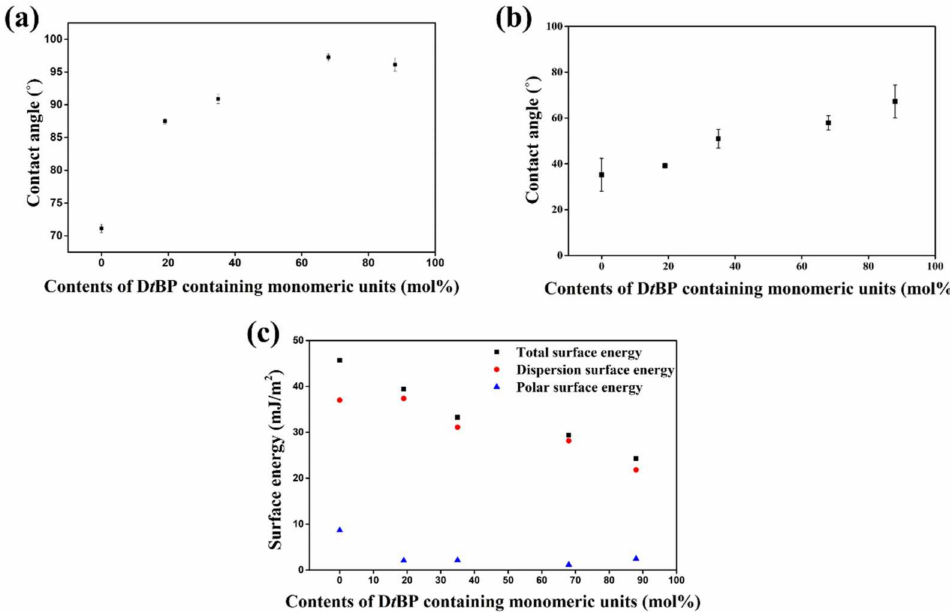
Figure 7. ( a ) Water contact angle, ( b ) diiodomethane contact angle, ( c ) surface energy values of PCMS,